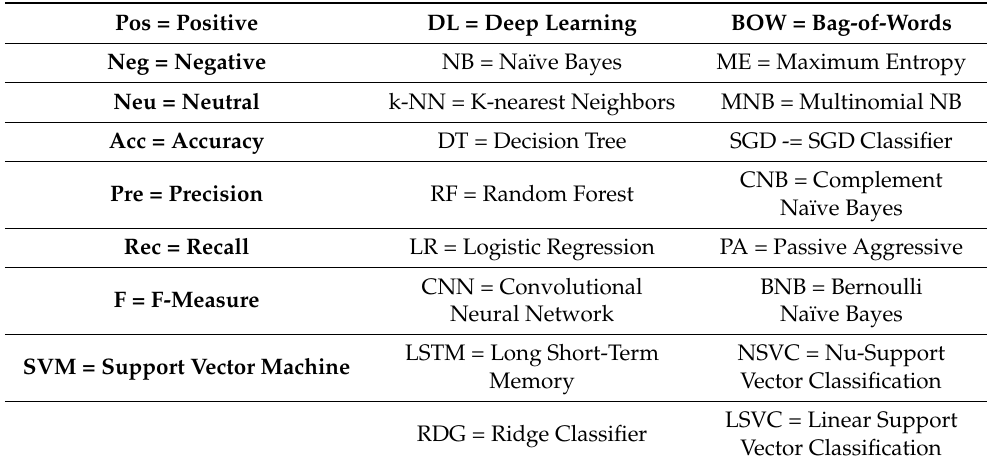
Table 2. Abbreviations.